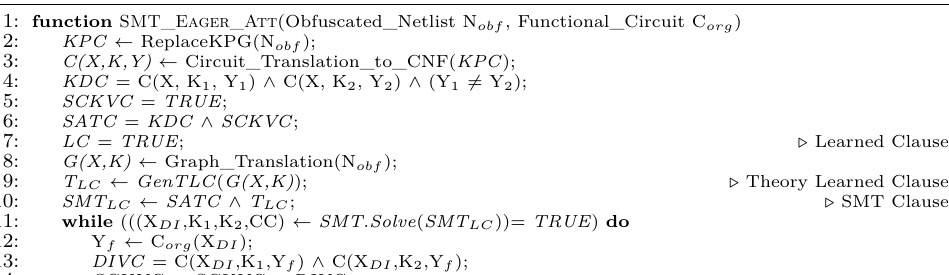
Algorithm 2 Eager SMT Attack on DLL